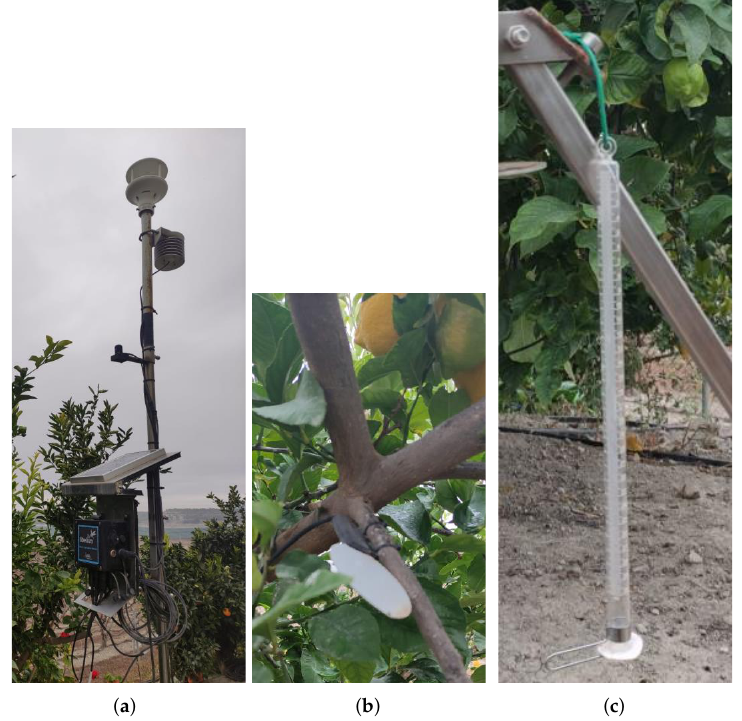
Figure 1. IoT infrastructure deployed for data collection. ( a ) Overview of IoT sensors deployed. ( b ) Detail of the leaf vaporisation sensor. ( c ) Piche evaporimeter model